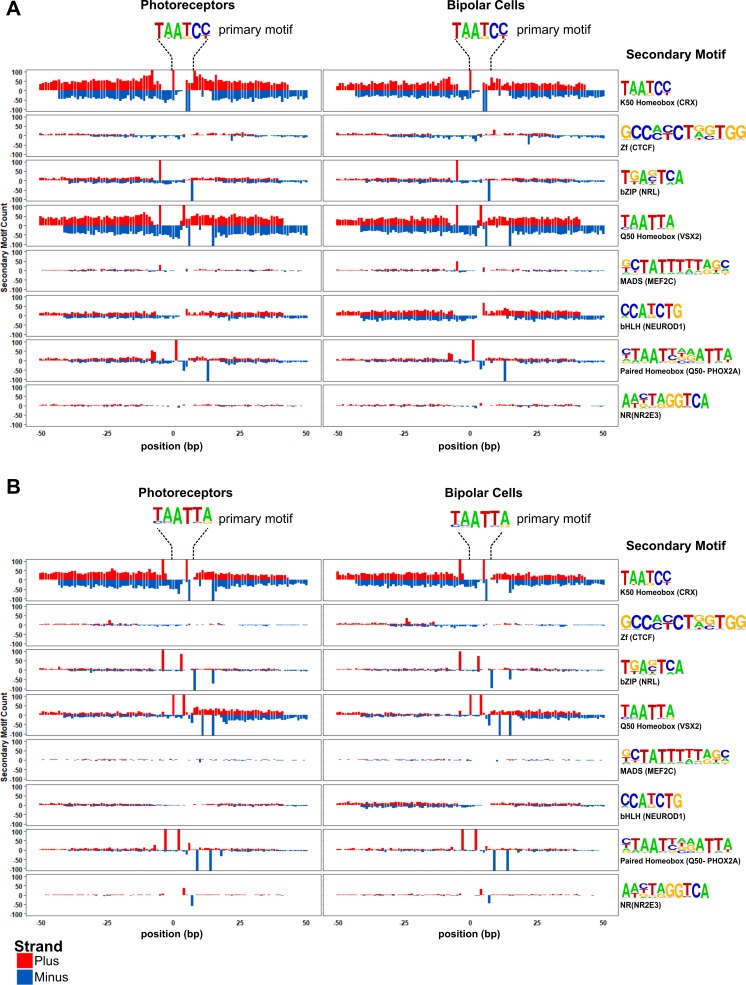
Motif spacing and orientation in photoreceptor and bipolar cells.Peaks from photoreceptors (left) and bipolar cells (right) are centered on K50 HD (A) or Q50 HD motifs (B). Per base-pair counts for secondary motifs (PWM and example TFs shown at the far right) are plotted in a 100 bp window surrounding the primary motif, with counts on the plus strand shown in red, and the minus strand shown in blue. The y-axis was limited to ± 100.